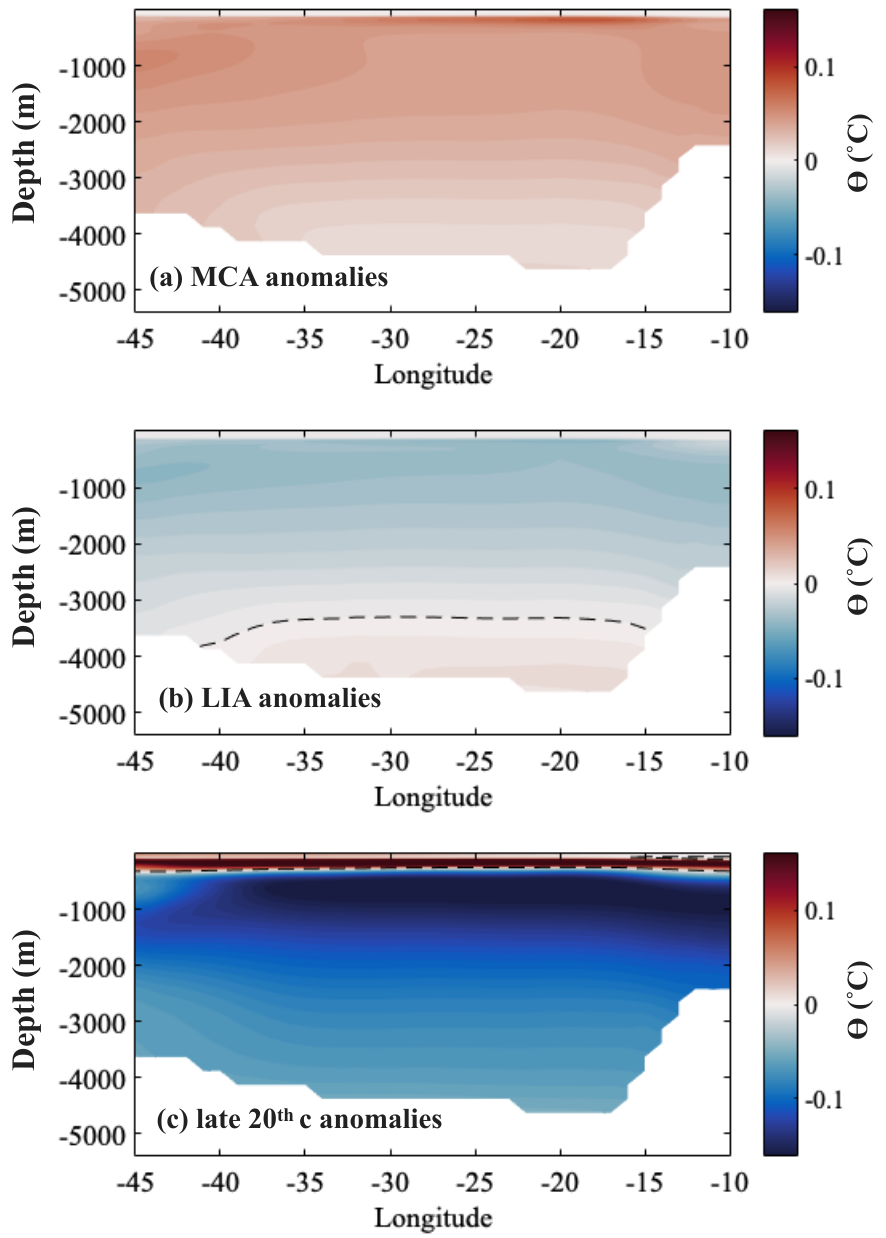
Figure 2. Potential temperature anomalies along the WS transect ( ◦ C) with respect to the pre–industrial Last Millennium (LM) base period (850–1850): ( a ) Medieval Climate Anomaly (MCA), between 950–1250; ( b ) Little Ice Age (LIA), between 1400–1699 and ( c ) late 20th century (Present), between 1970–1999 (in line with [59]). Warm/cold colors represent positive/negative anomalies. Black dashed lines represent the zero contour of θ